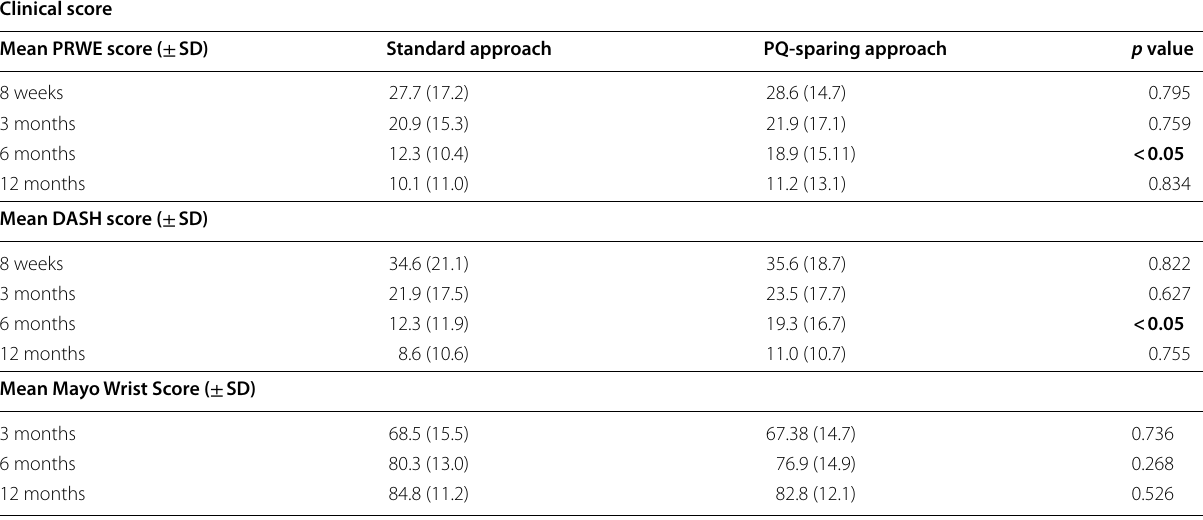
Bold values indicate p -value <